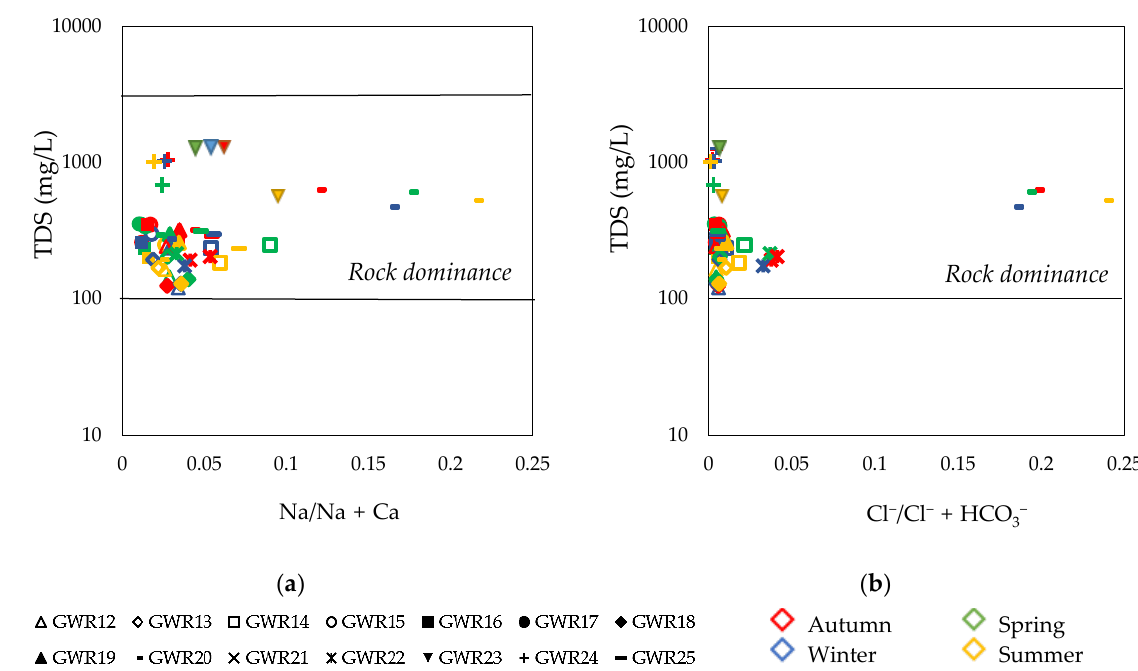
Figure 4. Gibbs diagram for the major ion composition of the studied karst water sources in the Apuseni Mountains: ( a ) Na/Na + Ca vs. TDS plot; ( b ) Cl − /Cl − + HCO 3 − vs. TDS plot.